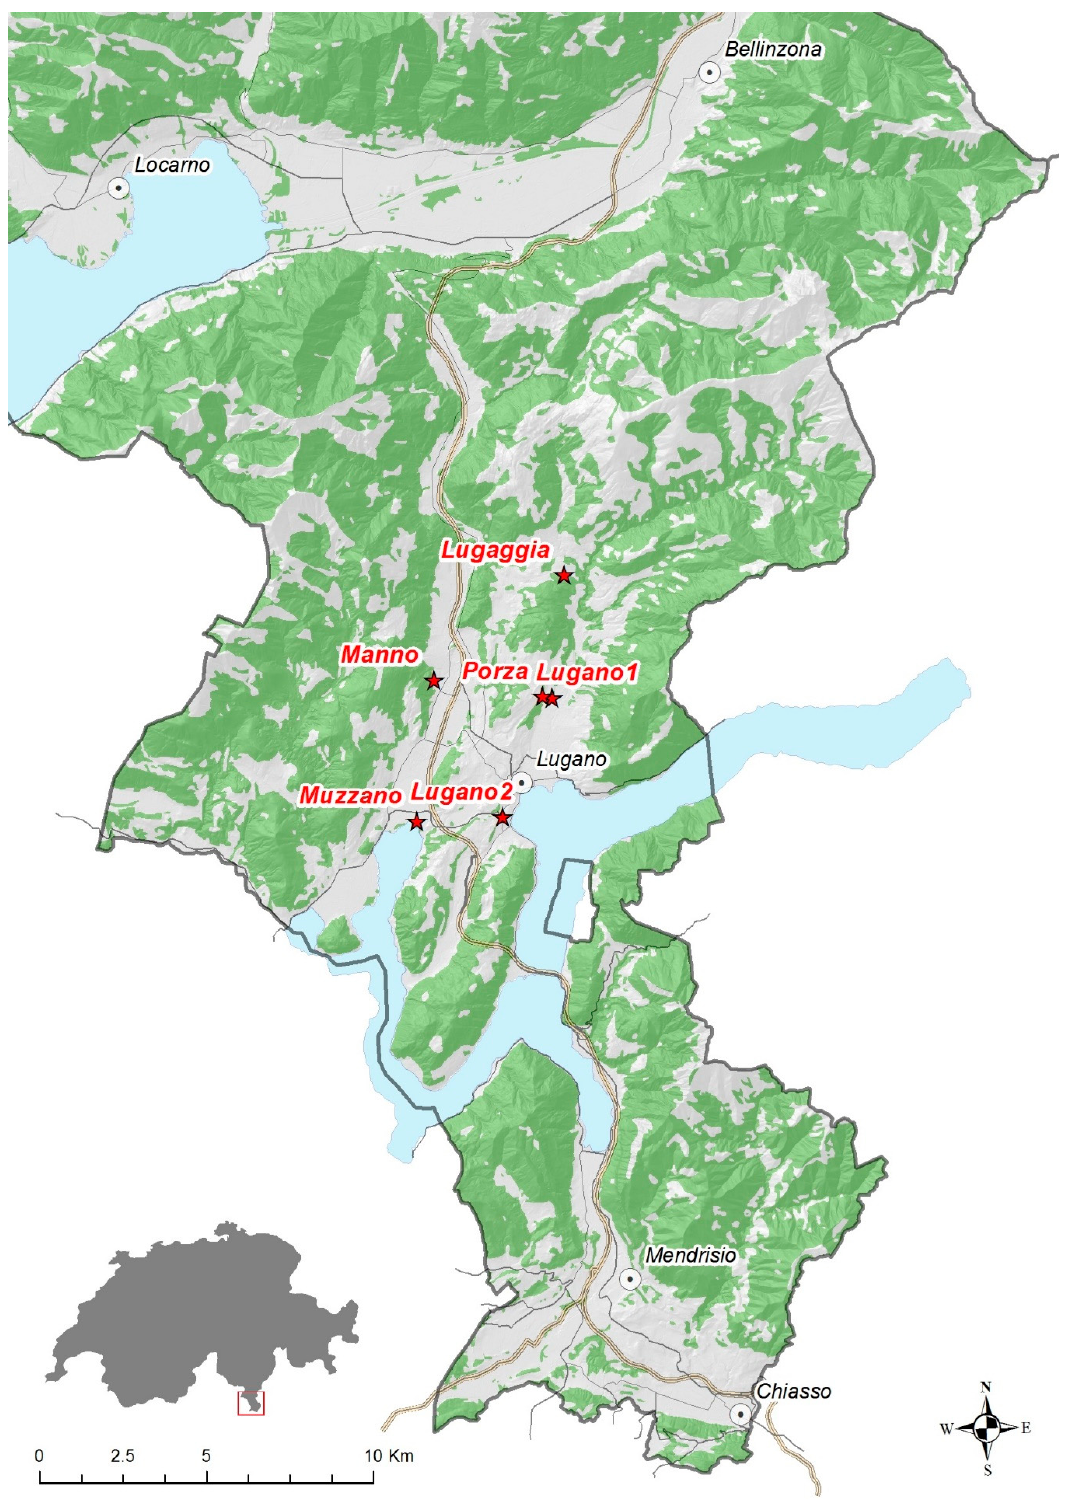
Figure 1. Locations of mosquito collection. Detailed coordinates and sample descriptions are given in Table 1.